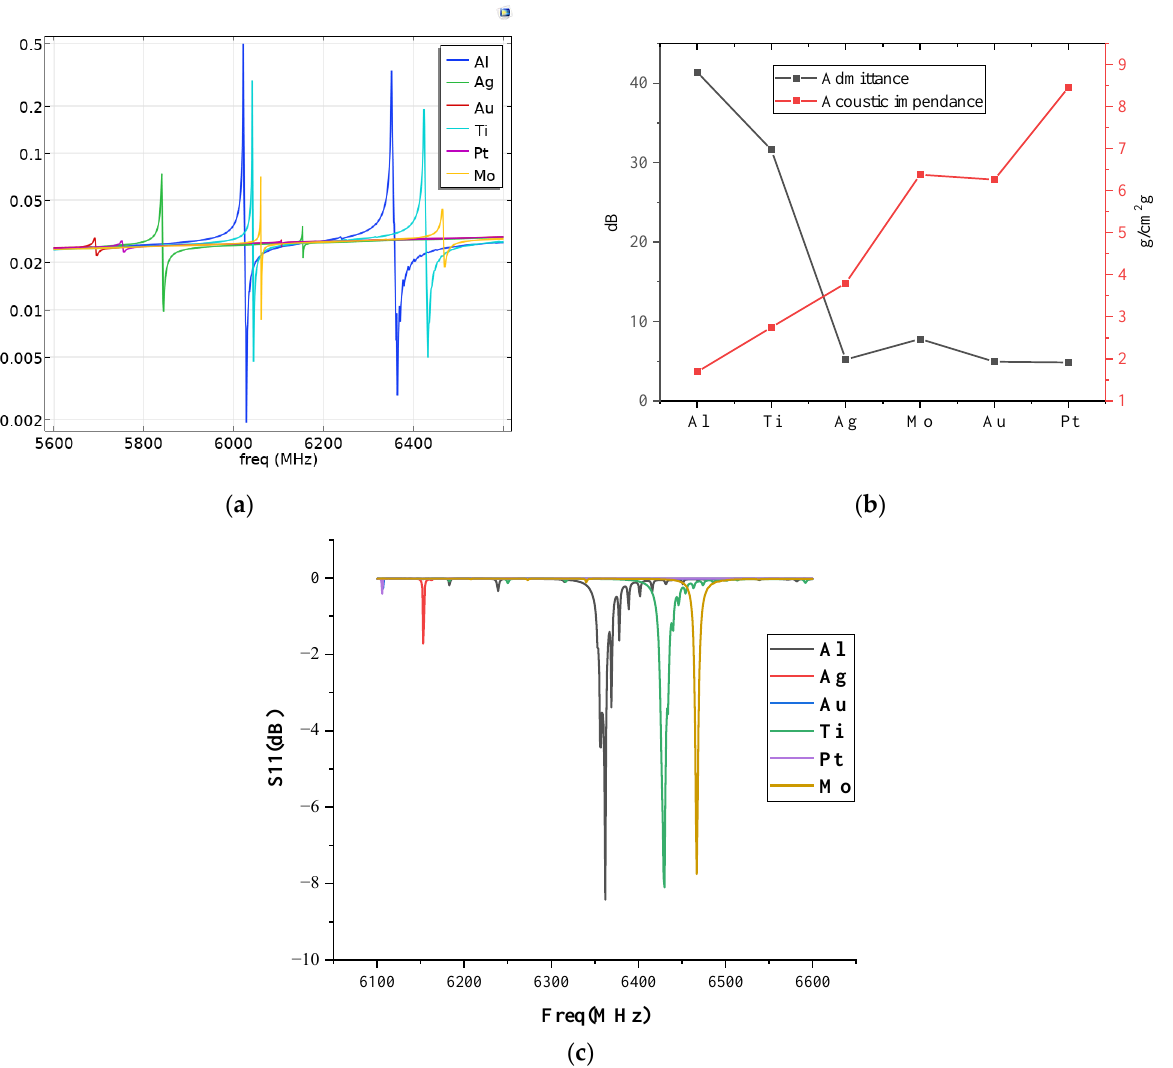
Figure 4. ( a ) Absolute value of the admittance for the electrode materials; ( b ) Relationship between the admittance amplitude and the acoustic impedance of the electrodes; ( c ) S11 reflection spectra of the electrode materials. Table 1. Young’s modulus and Poisson’s ratio of common polymer